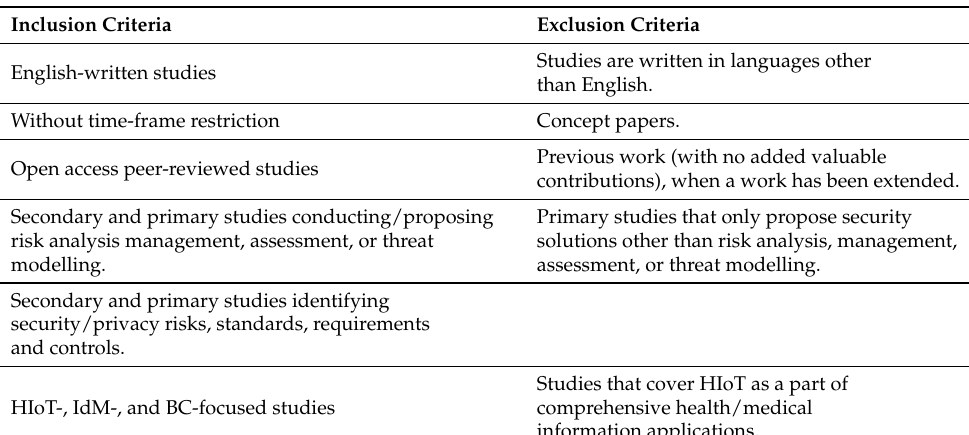
Table 5. The inclusion and exclusion criteria used in the